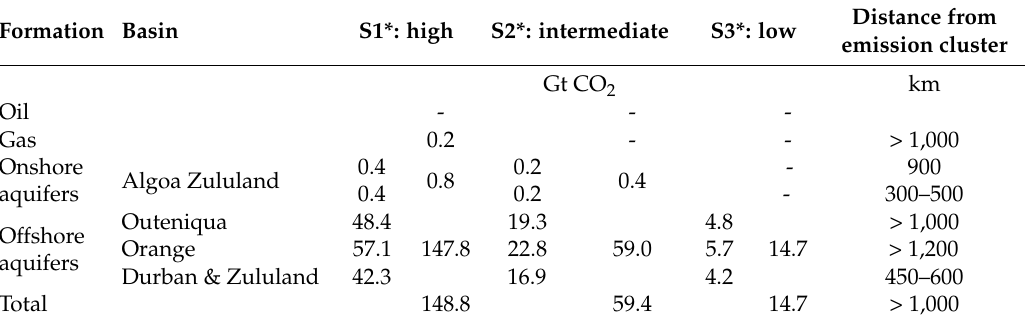
Table 2. Three scenarios of effective CO 2 storage capacity in South Africa, based on